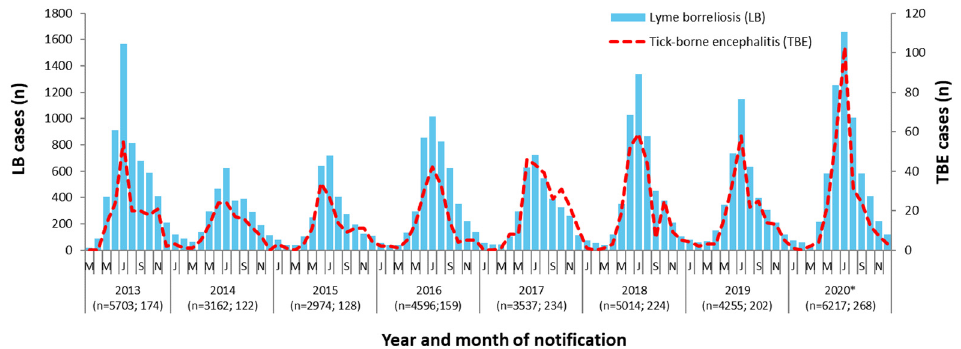
Figure 2. Reported cases of LB ( n = 35,458) and tick-borne encephalitis ( n = 1511) in Bavaria during the first 8 years of mandatory LB notification (March 2013–December 2020), by year and month of notification; numbers below year dates indicate annual notified LB and TBE cases, respectively; * the 2020 season was likely influenced by the COVID-19 pandemic and periods of lockdown (see discussion section).